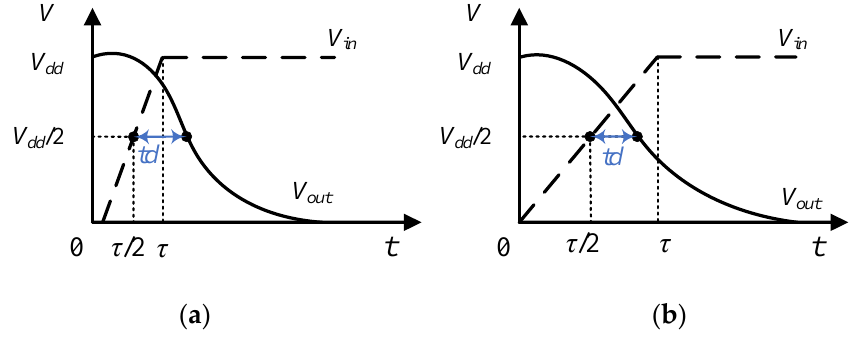
Figure 1. Gate delay td induced by input slew τ . ( a ) fast input; ( b ) slow input.